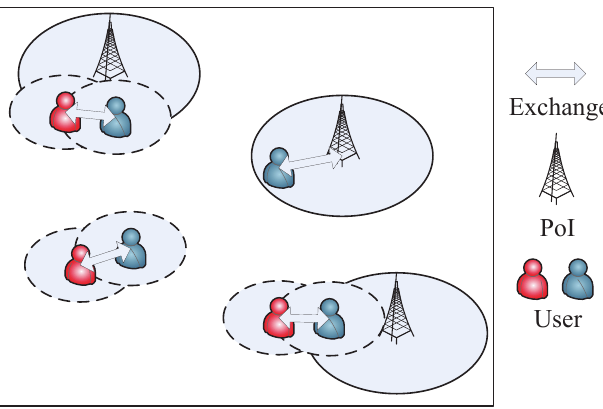
Figure 9. The communication conditions among the users and PoIs. The PoIs and the users are regarded as the same; they collect parameters and exchange with each